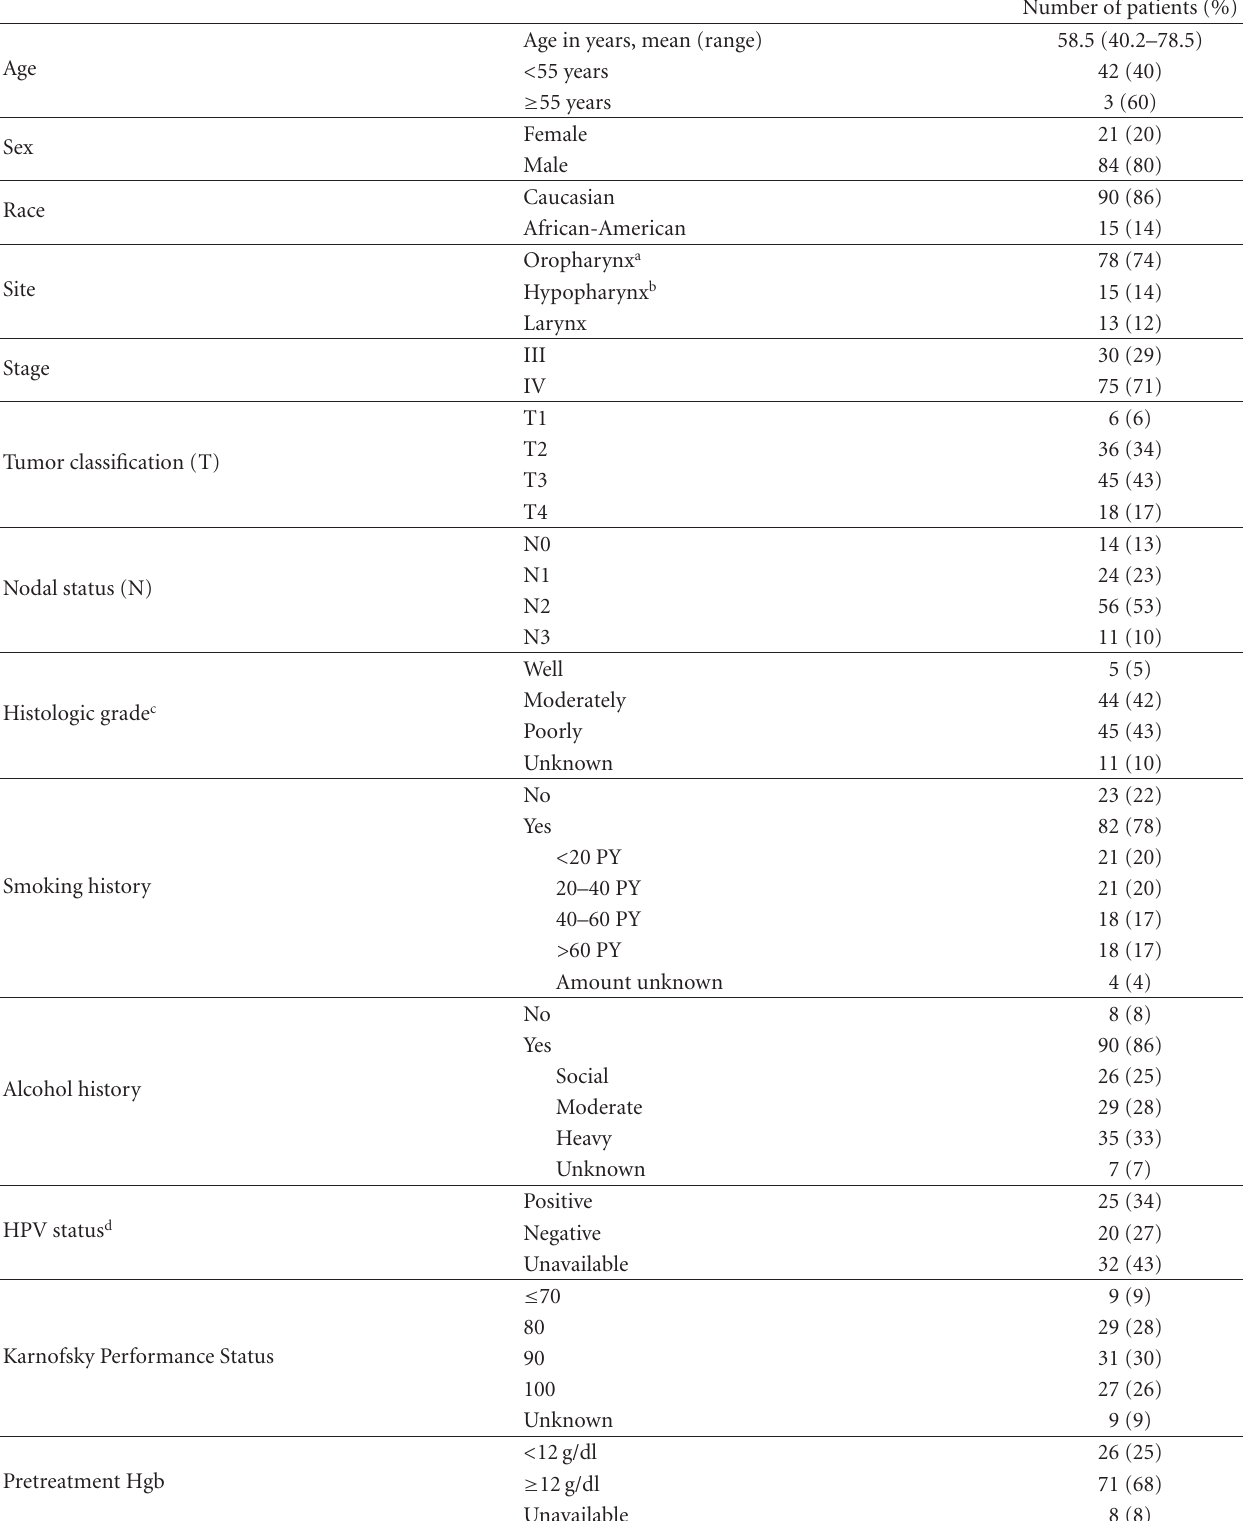
Table 1: Patient characteristics at baseline ( n =